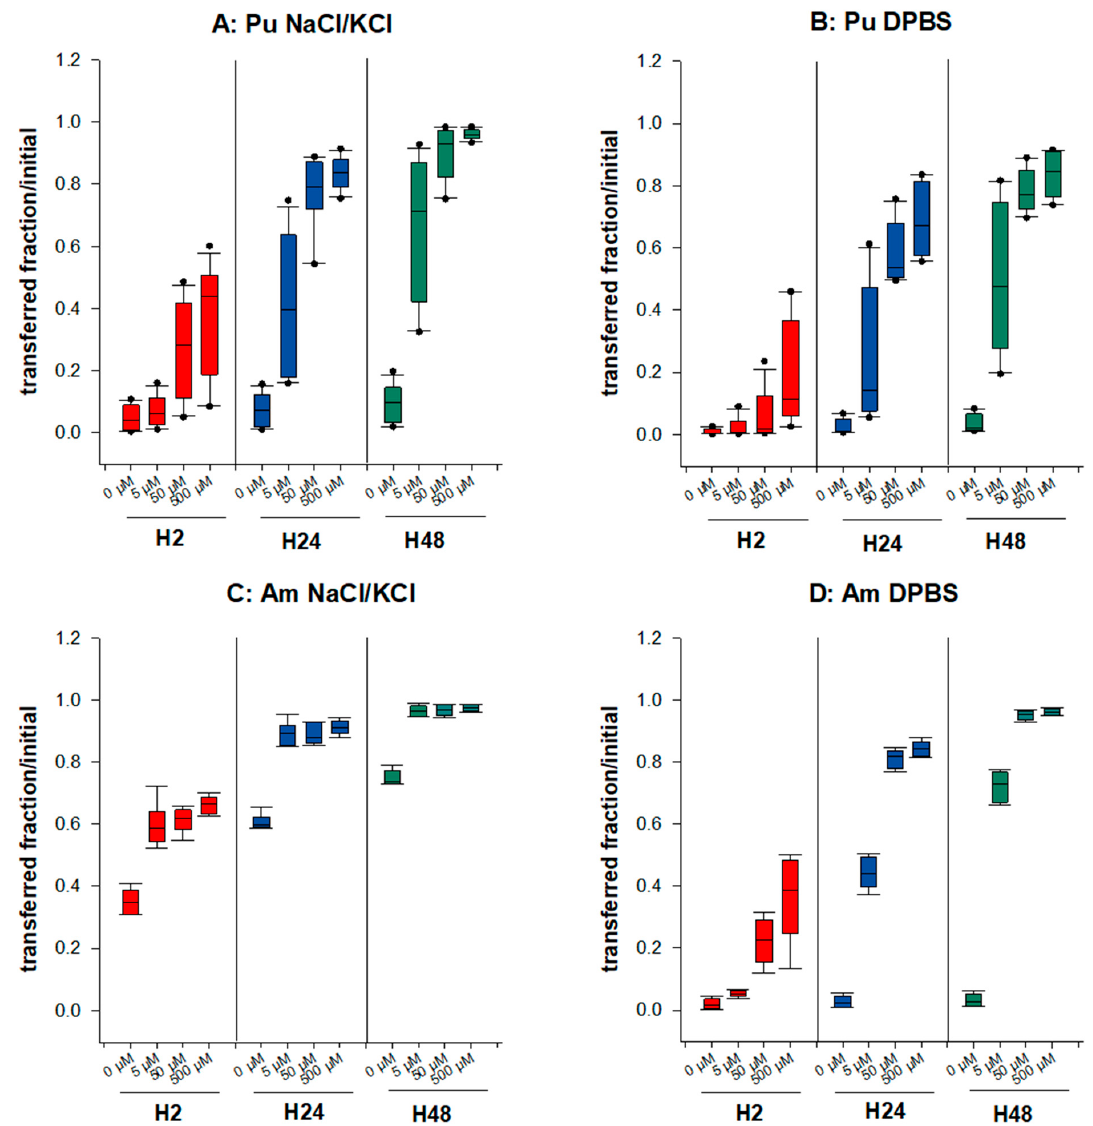
Figure 2. Transfer of Pu/Am in the presence of a synthetic ligand, DTPA. Pu ( A , B ) or Am ( C , D ) were included in the static retention phase (agarose gels) prepared in NaCl/KCl ( A , C ) or in DPBS ( B , D ). After 2, 24, and 48 h incubation in NaCl/KCl or DPBS supplemented or not with DTPA (5, 50, 500 µM), the transferred activity was measured in the dynamic phase using liquid scintillation counting. Results are expressed as cumulative activity/initial activity in the gel. Each experimental condition was done in triplicate and repeated 4 times for Pu in NaCl/KCl, 3 times for Pu in DPBS, and twice for Am in NaCl/KCl or